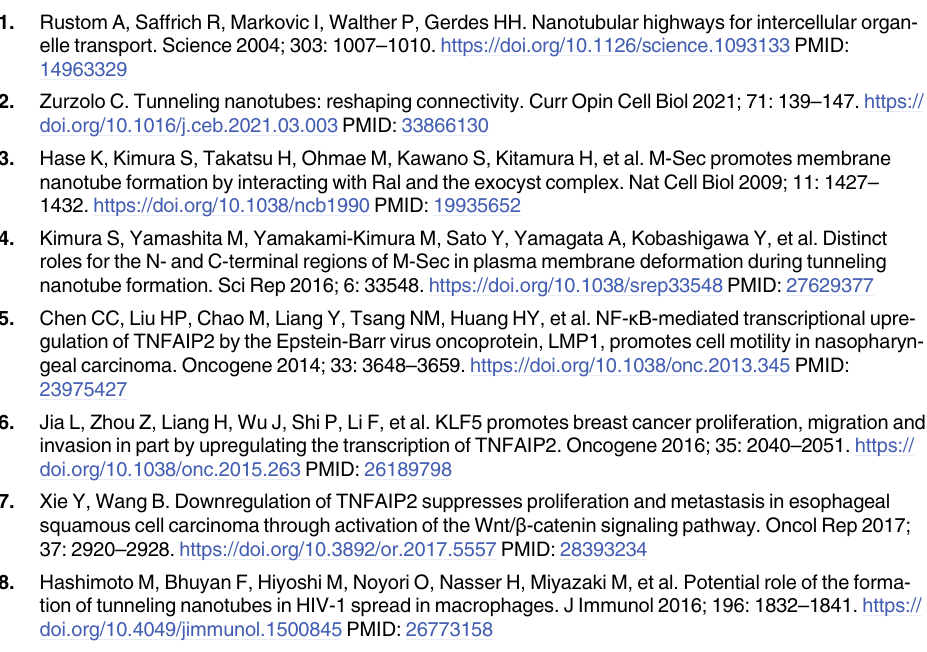
S2 Video. Intracellular distribution of Gag in M-Sec knockdown MT-2 cells. M-Sec knock- down MT-2 cells were analyzed for Gag (red). The nuclei were also stained with DAPI (blue).